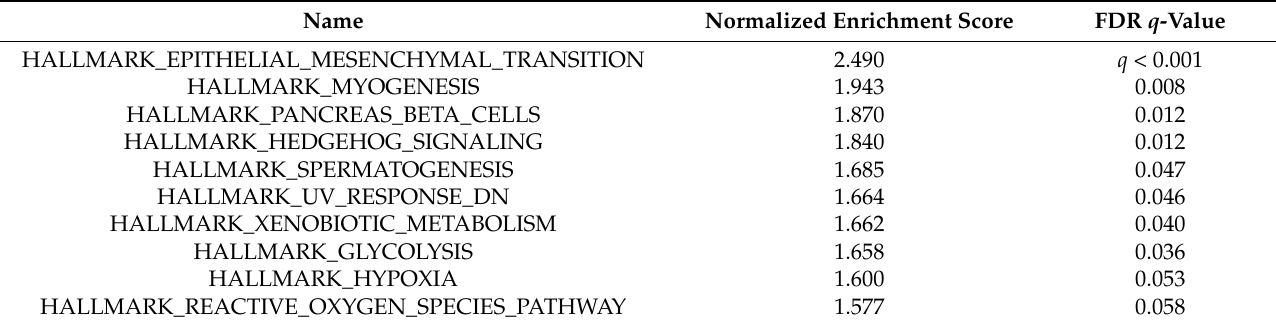
Figure 10. PFN2 -mediated pathways identified by gene set enrichment analysis: ( A ) the top 10 enriched gene sets in the high PFN2 expression group; ( B ) enrichment plot of “epithelial–mesenchymal transition”. Table 2. The top 10 enriched gene sets in the high PFN2 expression group.